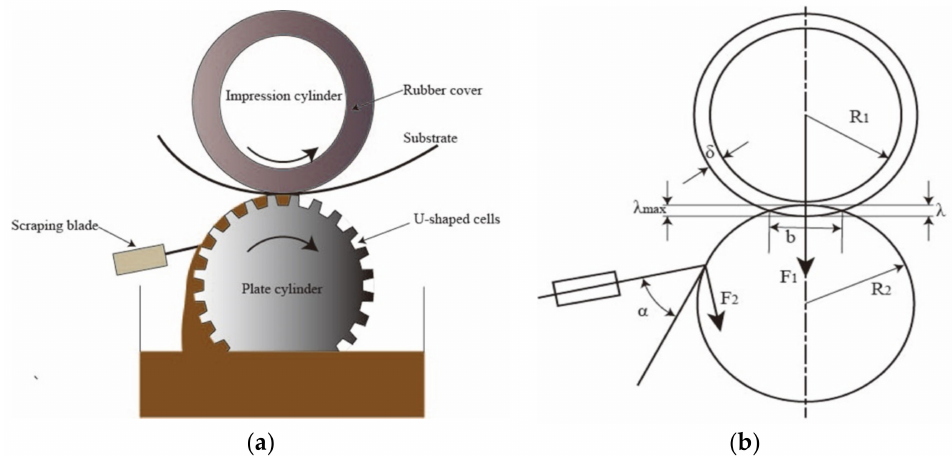
Figure 5. ( a ) Working schematic diagram of the printing plate. ( b ) Contact force analysis of the printing plate